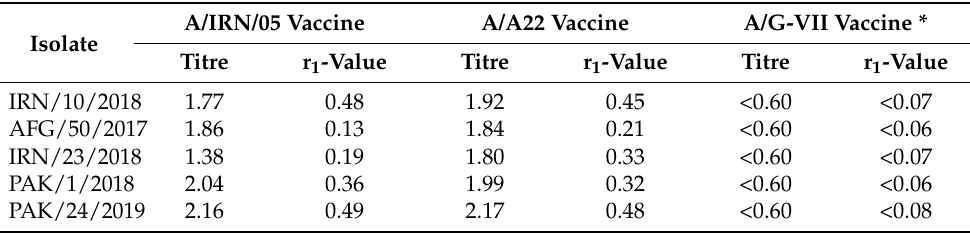
Table 1. Antigenic match between a selection of antiserum raised against serotype A vaccines and representative A/ASIA/Iran/05 SIS − 13 field isolates. These data are reported as the log 10 reciprocal of the heterologous neutralisation titres (titre) and serological vaccine matching values (r 1 -value); r 1 -values below 0.3 indicate a significant difference between the vaccine virus and the field isolate. Bovine Vaccinated Sera (BVS) for the vaccine strains compared were provided by Boehringer Ingel- heim. * The isolates did not show any detectable neutralising antibody titres against A/G-VII bovine vaccinate sera and hence represented as <0.60 and, accordingly, the r 1 -values are represented as less than the expected value if the titres were